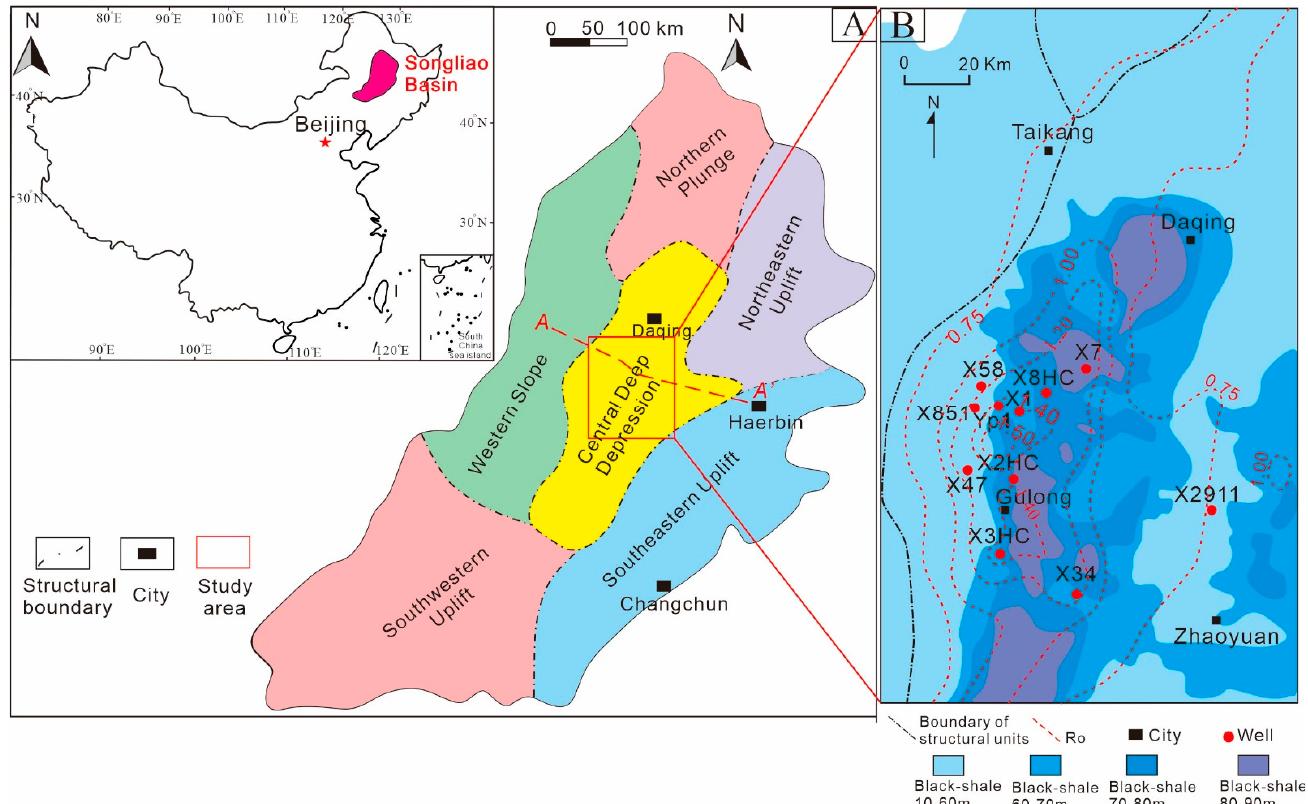
Figure 1. Geological map of the study area. ( A ) Location of the Songliao Basin in China and its structural units. ( B ) Detailed map showing the study area with existing wells.